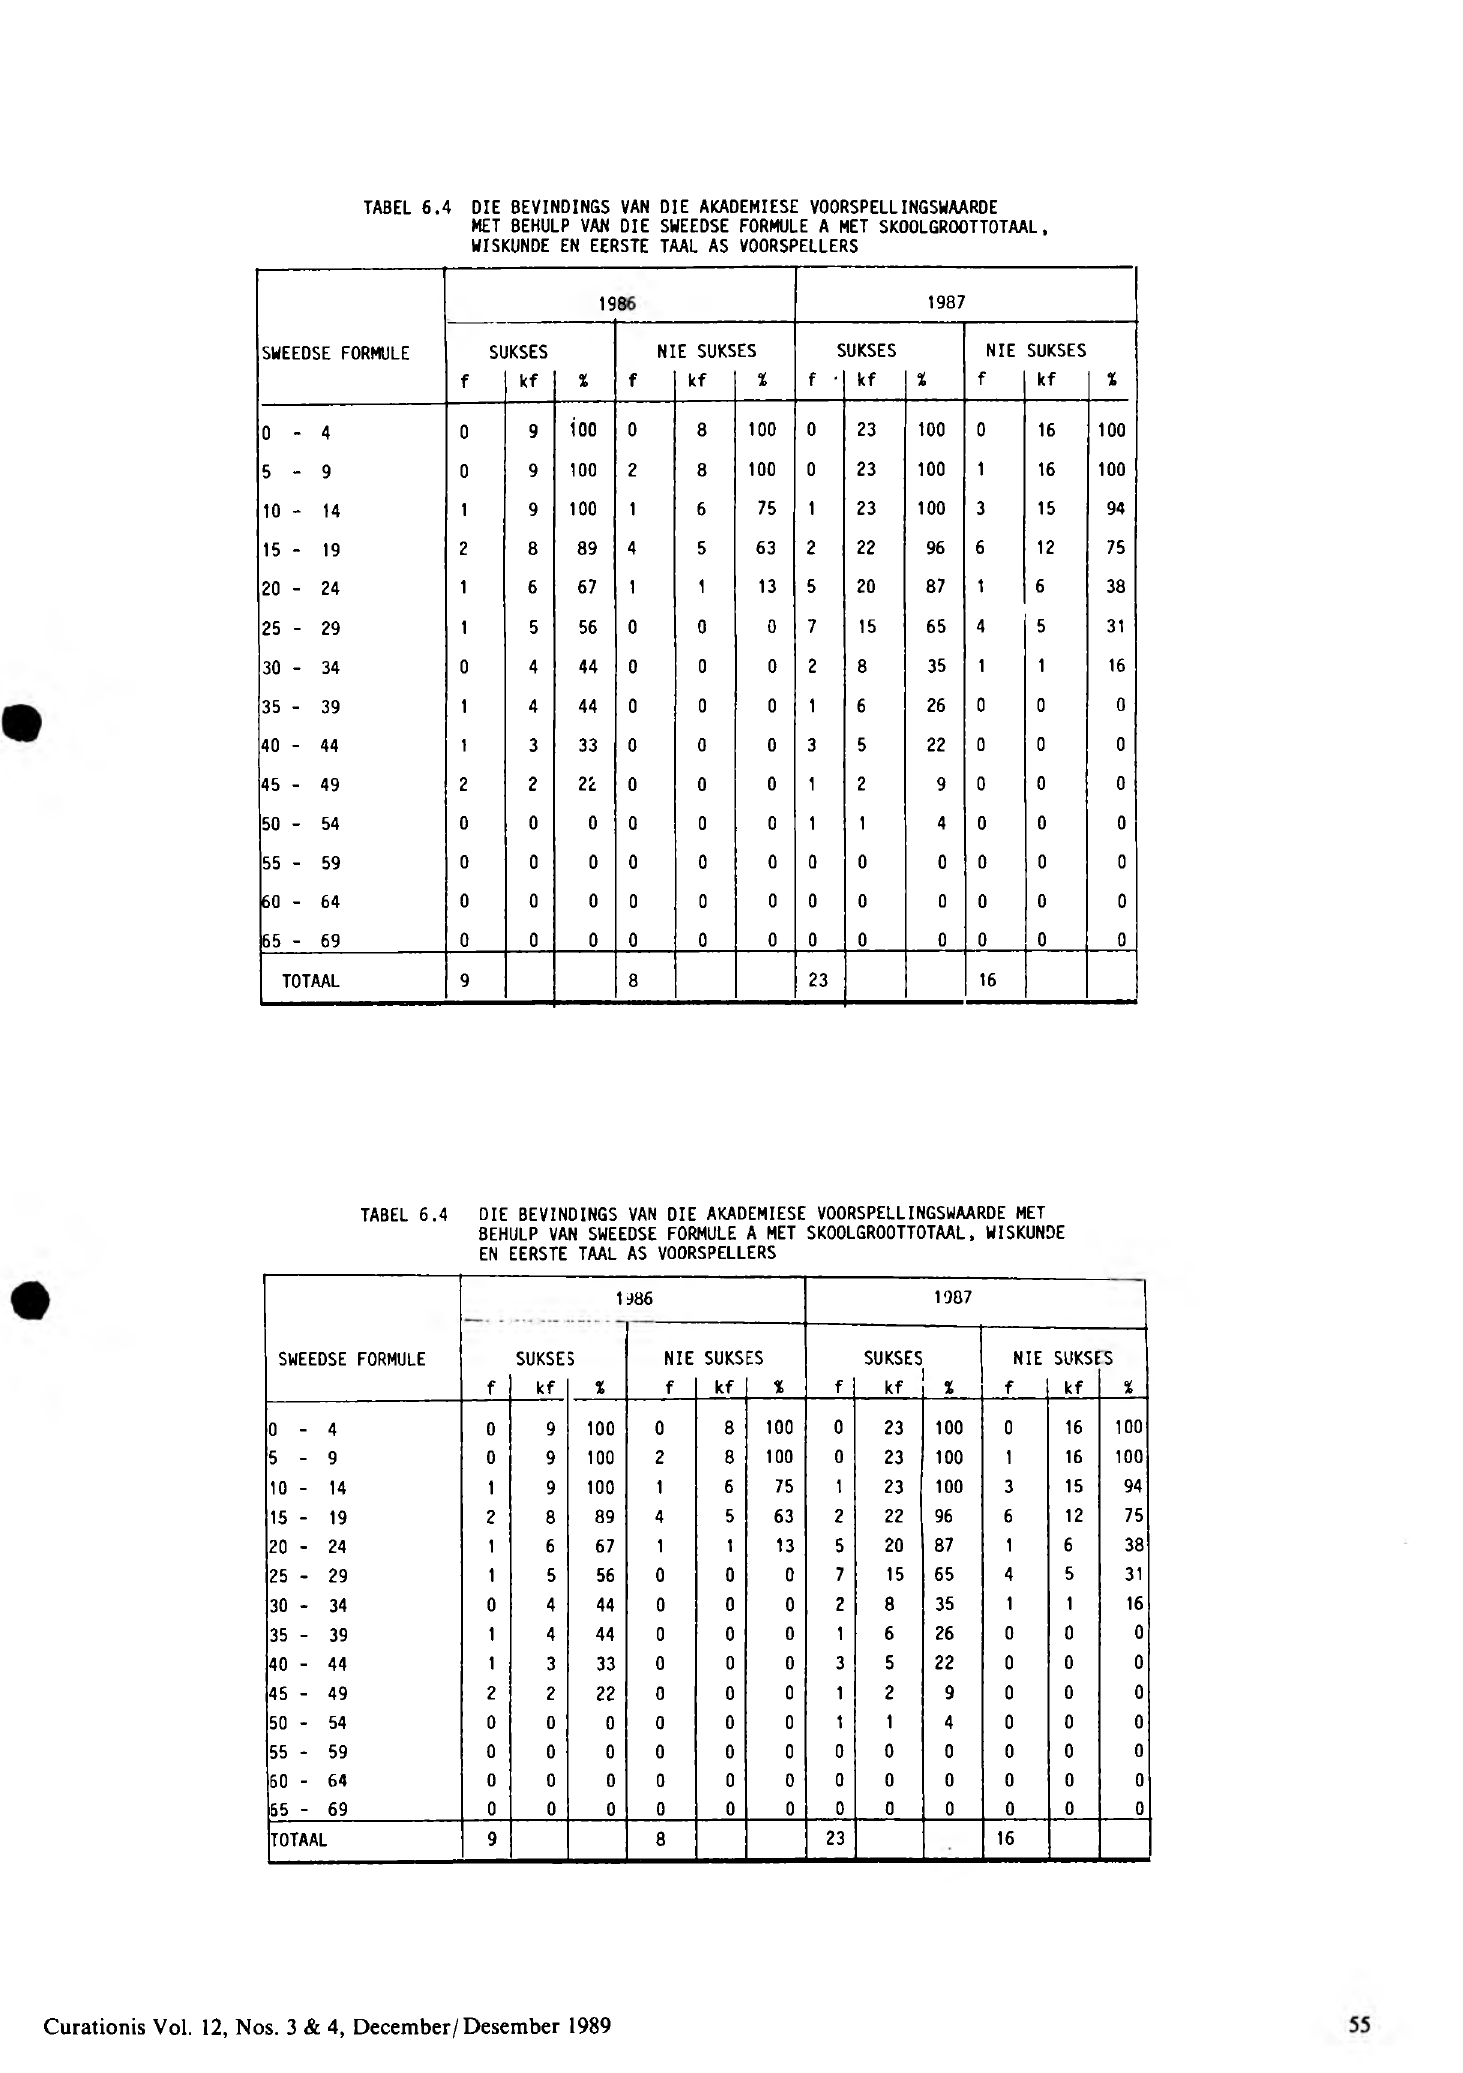
TABEL 6.4 DIE BEVINDINGS VAN DIE AKADEMIESE VOORSPELLINGSWAARDE MET BEHULP VAN DIE SWEEDSE FORMULE A MET